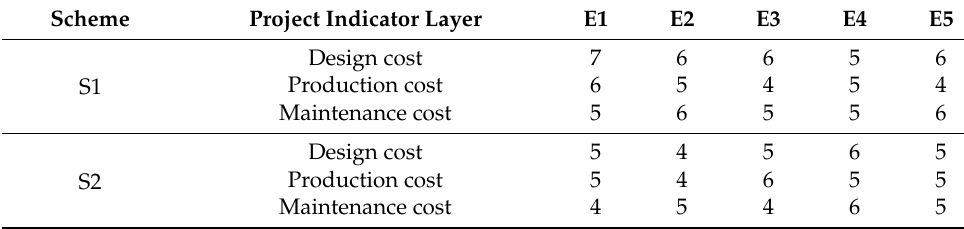
Table A2. Evaluation results of economic performance.